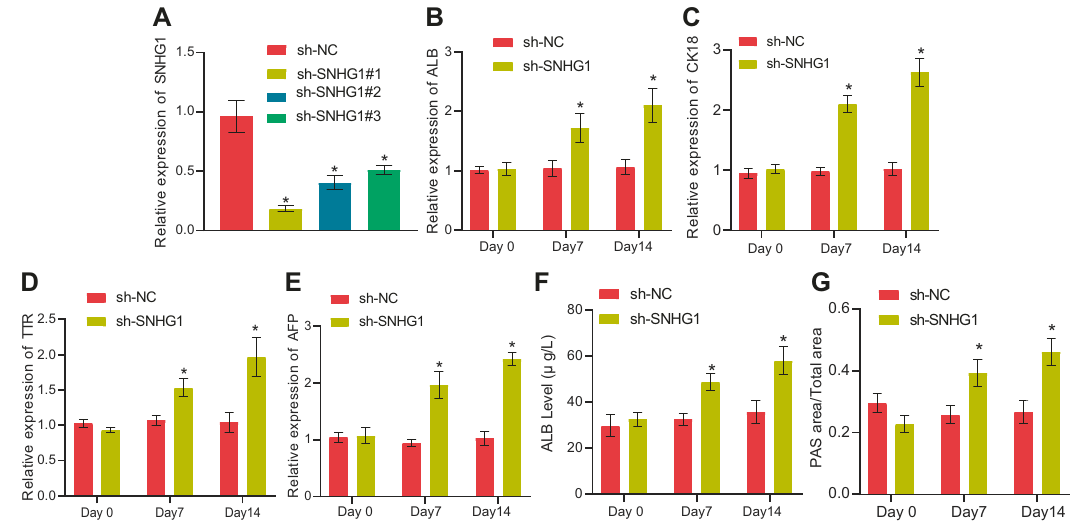
Fig. 2 Silencing lncRNA SNHG1 promotes BMSCs to differentiate to HLCs. A Validation of lncRNA SNHG1 silencing ef fi ciency by RT-qPCR. B RT-qPCR detection of the changes of ALB levels at day 0, 7, 14 after silencing of lncRNA SNHG1. C RT-qPCR detection of the changes of CK18 levels at day 0, 7, 14 after silencing of lncRNA SNHG1. D RT-qPCR detection of the changes of TTR levels after 0, 7, 14 days after silencing of lncRNA SNHG1. E RT-qPCR detection of the changes of AFP levels at day 0, 7, 14 after silencing of lncRNA SNHG1. F ELISA to detect the ALB content in the culture supernatant of BMSCs at day 0, 7, and 14 after silencing of lncRNA SNHG1. G Glycogen content in BMSCs at day 0, 7, and 14 after silencing of lncRNA SNHG1 determined by PAS staining. * p < 0.05 vs . BMSCs transfected with sh-NC. The cell experiments were repeated three